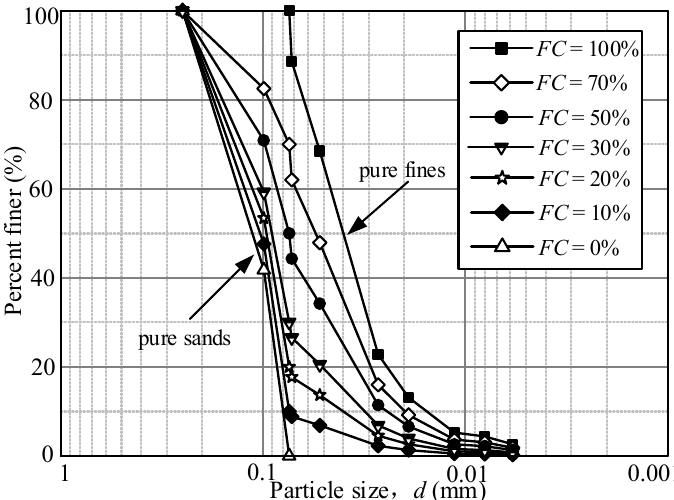
Figure 2. The particle size distribution curves of the sand-silt mixtures.